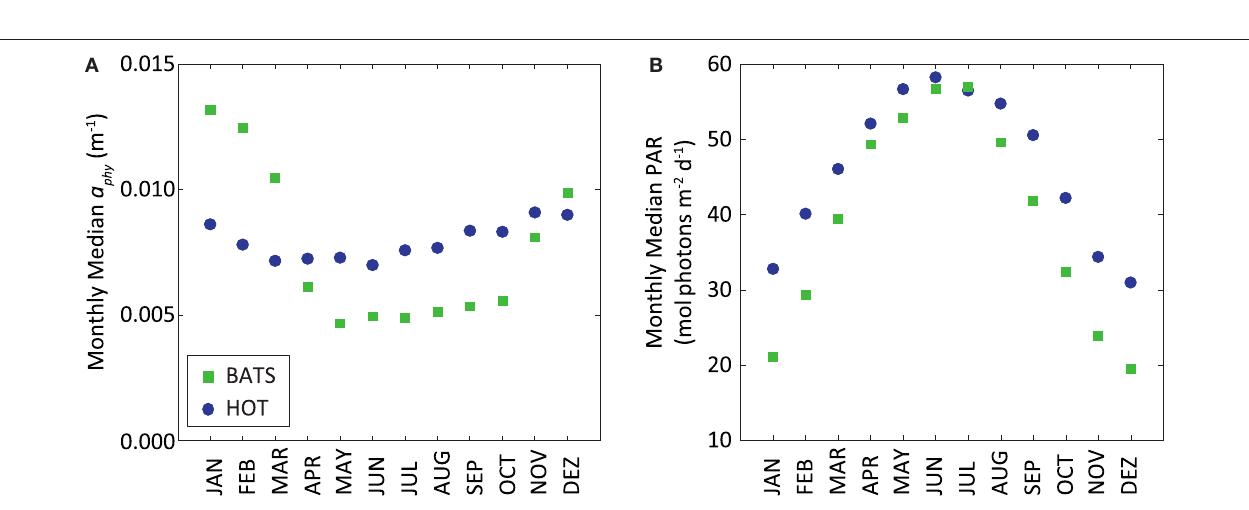
red curve). These findings support then the need of regional in situ measurements and incorporating temporal dependence on photosynthetic parameters according to the study area. It